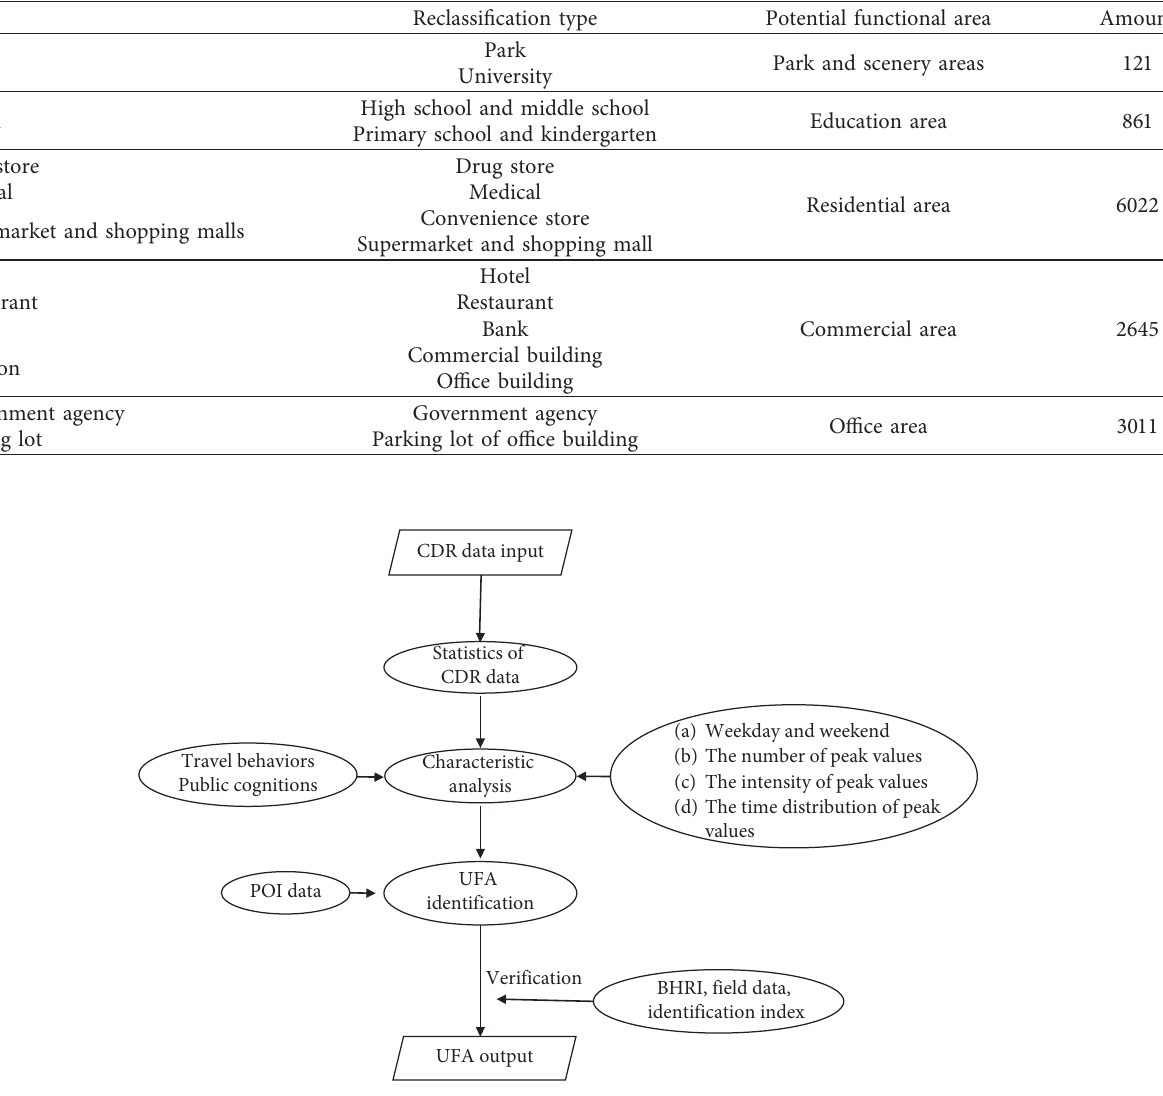
Table 5: POI reclassification based on Chinese land use